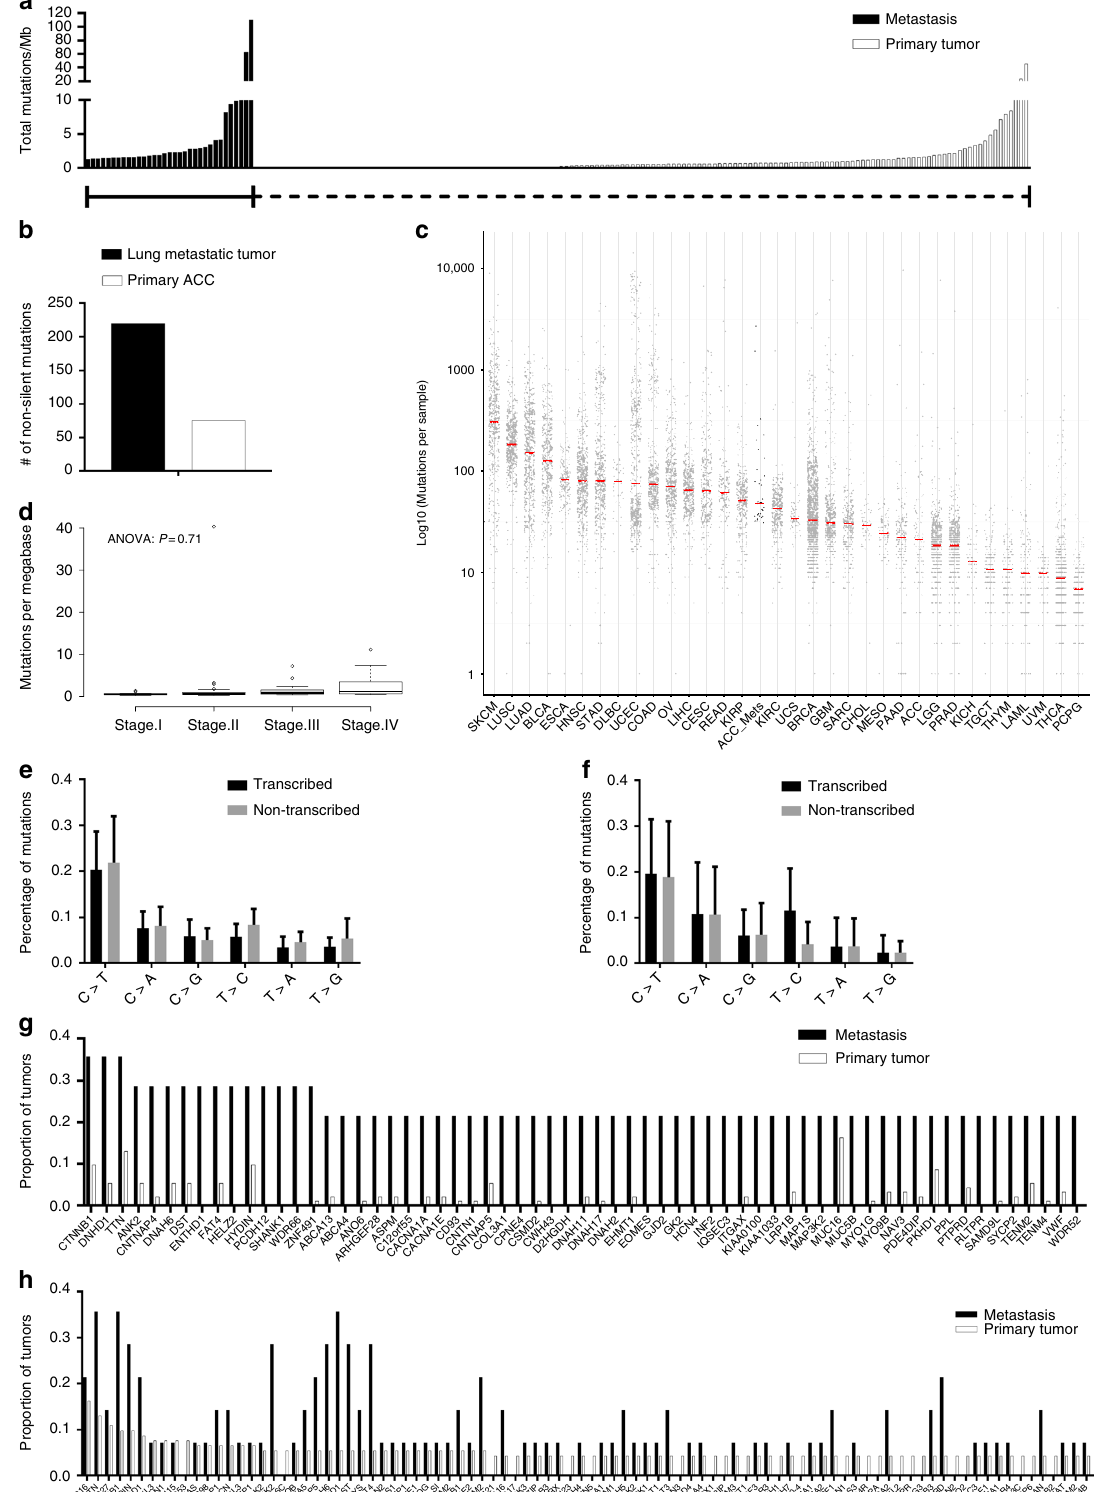
Fig. 1 Metastatic ACC has a higher mutation burden compared to primary ACC. Total number of mutations per megabase in each tumor sample of both metastatic and primary ACC (TCGA). Each bar on x -axis represents a patient or a tumor sample ( a ). Total mutations per megabase in metastatic lung ACC and its counterpart primary ACC tumor from the same patient ( b ). Metastatic ACC mutation rate compared to other cancer types including primary ACC (TCGA) ( c ). Mutation rate in the primary ACC (TCGA) based on tumor stage ( d ). Relative proportions of the six possible base-pair mutations in 33 metastatic ACC ( e ) and primary ACC ( f ). The top genes that are frequently mutated in metastatic ( g ) and primary ACC ( h